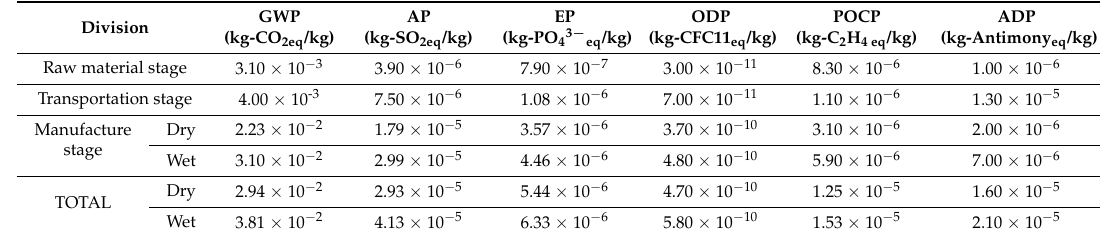
Table 4. Life cycle impact assessment of recycled aggregate; GWP: Global Warming Potential; ADP: Abiotic Depletion Potential; ODP: Ozone Depletion Potential; AP: Acidification Potential; EP: Eutrophication Potential; POCP: Photochemical Ozone Creation